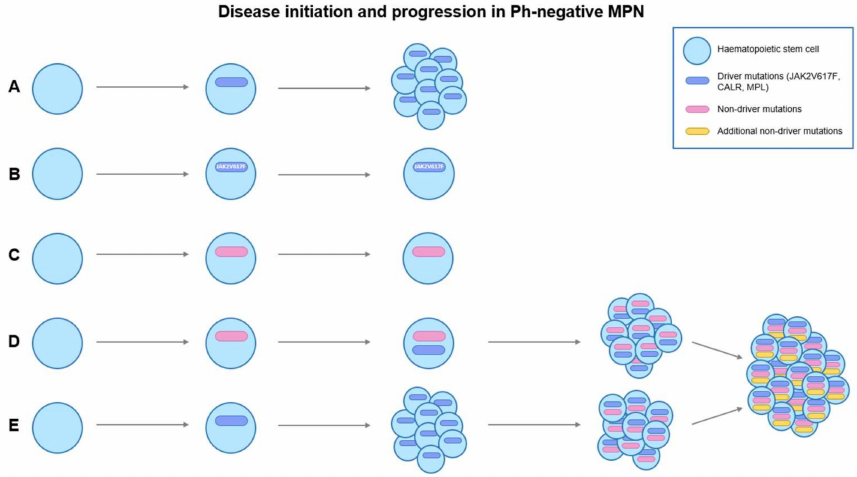
Figure 2. Disease initiation and progression in Ph-negative MPNs. ( A ) shows the acquisition of somatic driver mutations ( JAK2V617F, CALR, MPL ) in a haematopoietic stem cell (HSC), leading to myeloproliferation. ( B ) shows the acquisition of somatic driver mutation, JAK2 V617F, in HSC without progression to MPN. One of the reasons is the insufficient JAK2 V617F allele burden to give rise to a MPN phenotype. ( C ) shows the acquisition of non-driver mutations without progression to MPN, indicating the presence of clonal hematopoiesis of indeterminate potential (CHIP). ( D ) The presence of CHIP increases the chance of HSC to acquire driver mutations, leading to myeloprolifera- tion. ( D , E ) Acquisition of additional non-driver mutations in MPN stem cells could lead to disease progression or leukemic transformation to secondary acute myeloid leukemia